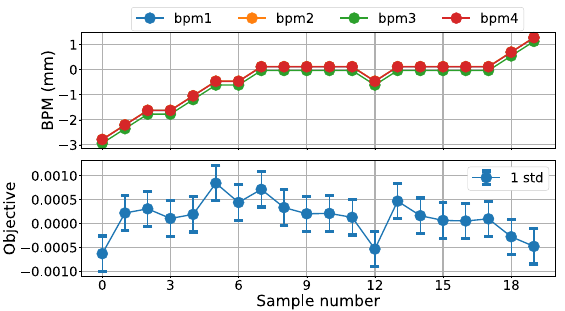
FIG. 8. Demonstration of the volatility of the original objective function. Due to the use of point δ values in λ ¼ ð 1 = δ Þð d δ =dt Þ and the noise in δ , the original objective varies too fast (bottom) even when the algorithm converges to an optimum strategy (top, e.g., from step 7 to 11 or 13 to 17). This eventually makes the algorithm diverge (after step 17) as the algorithm does not have enough time to learn properly the correlation between the inputs and outputs. algorithm. By tuning r the objective function ’ s sensitivity